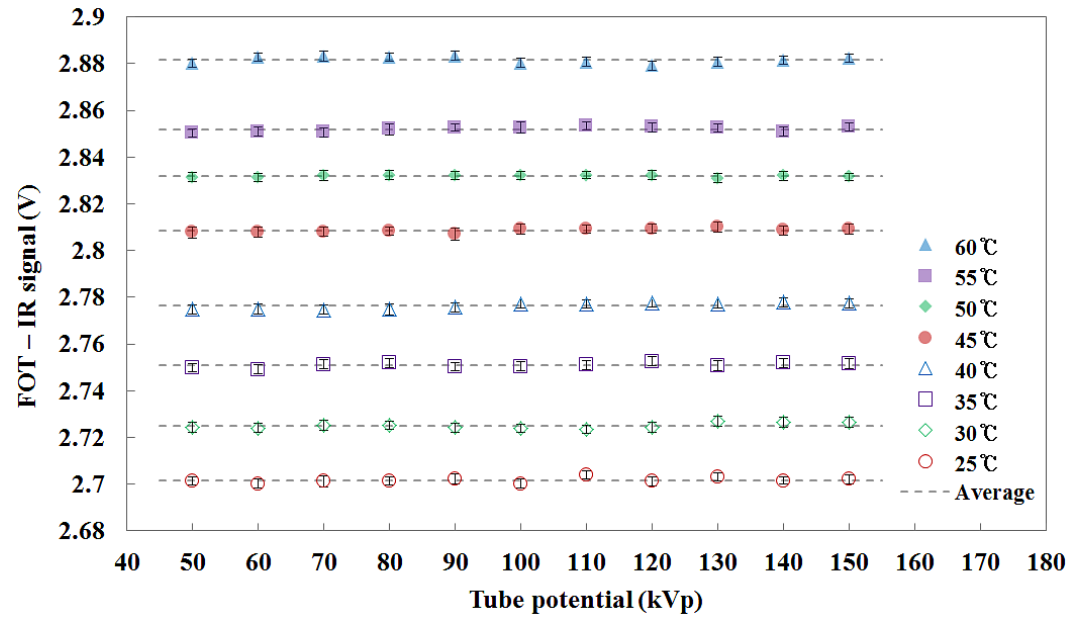
Figure 11. IR signal measurements of the FOT under changing tube potential conditions of the DR